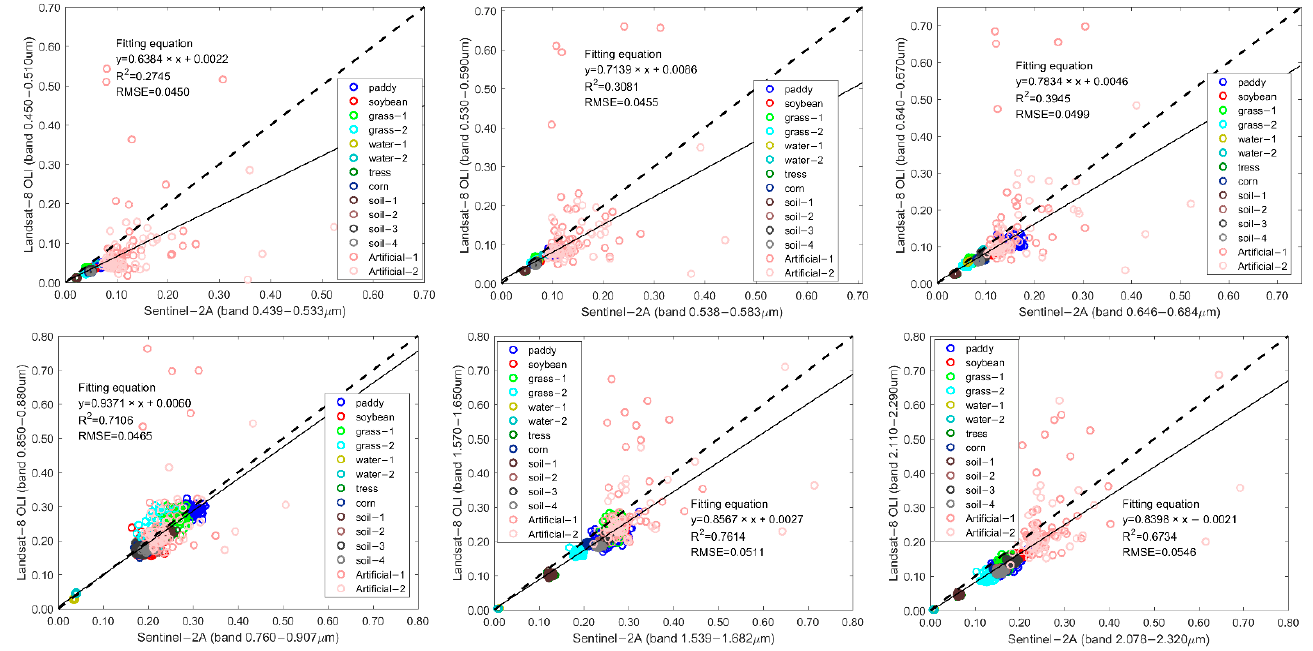
Figure 4. Statistical results by pseudo − invariant point feature with single − band data.